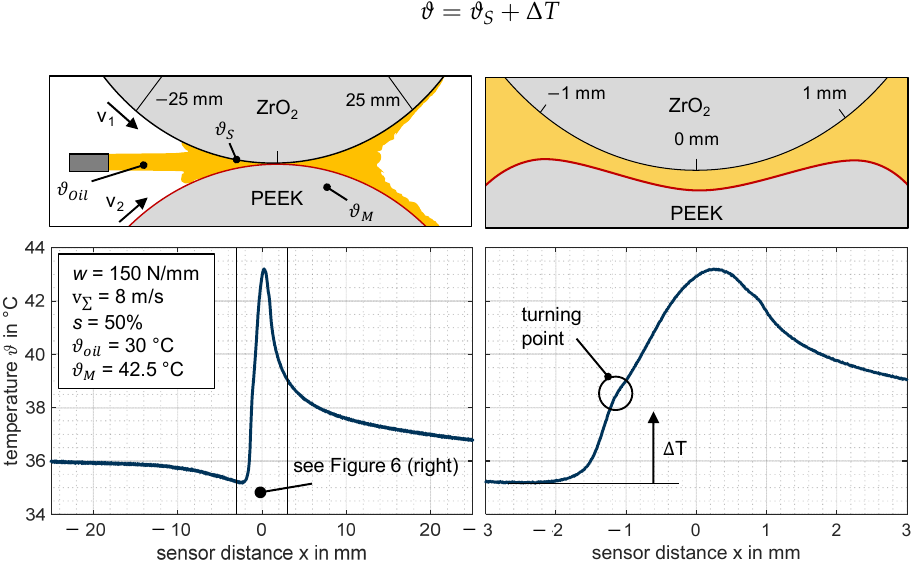
Figure 6. Exemplarily measured temperature profile with an illustration of the trajectory on the sensor disk considered with magnification of the contact area for the thermoplastic EHL contact ZrO 2 /PEEK without pressure correction (line load w = 150 N/mm, sum velocity v ∑ = 8 m/s, slip ratio s = 50%, oil temperature ϑ oil = 30 ◦ C,